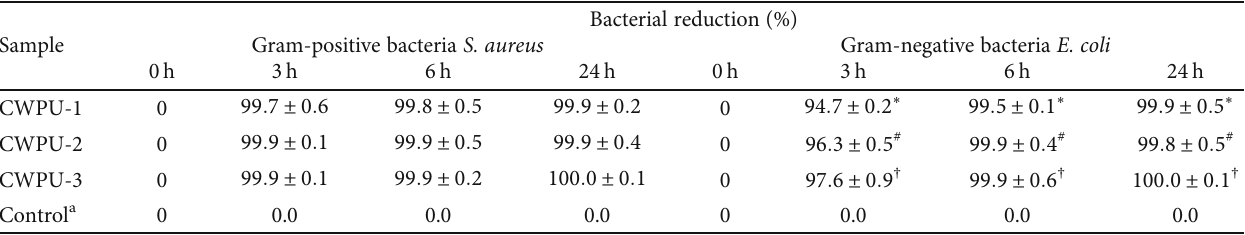
Table 7: Bacterial reduction of Gram-positive bacteria S. aureus and Gram-negative bacteria E. coli after incubation with cationic waterborne polyurethane (CWPU) fi lms for 0, 3, 6, and 24 h evaluated by the shaking fl ask method. Bacterial reduction (%) Sample Gram-positive bacteria S. aureus Gram-negative bacteria E.